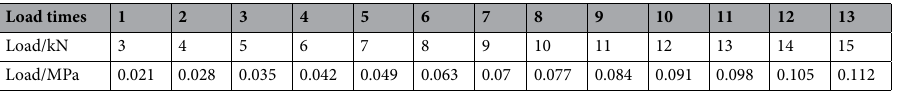
Table 5. Loading